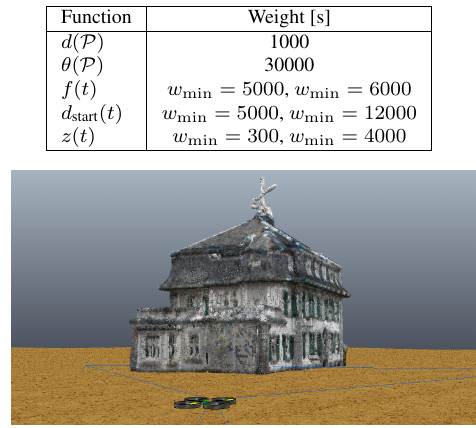
Table 1. Weights used in the cost function in our implementation.